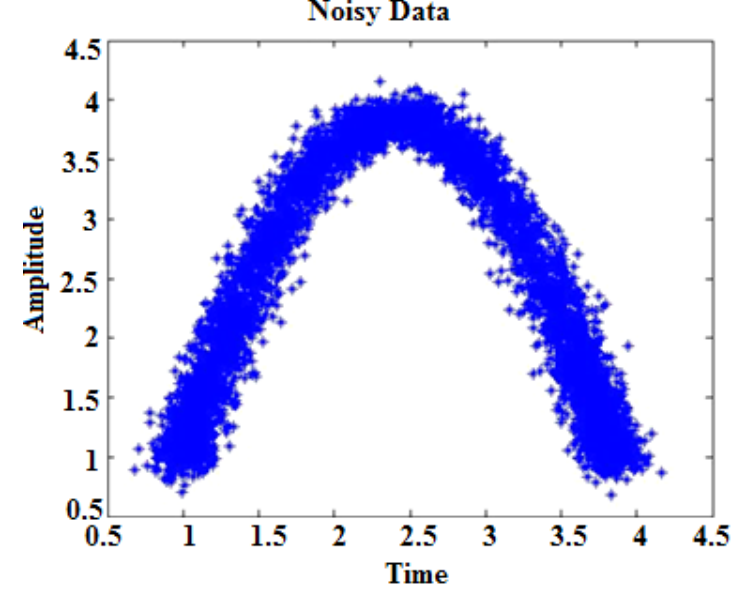
Figure 6. Gaussian noise.